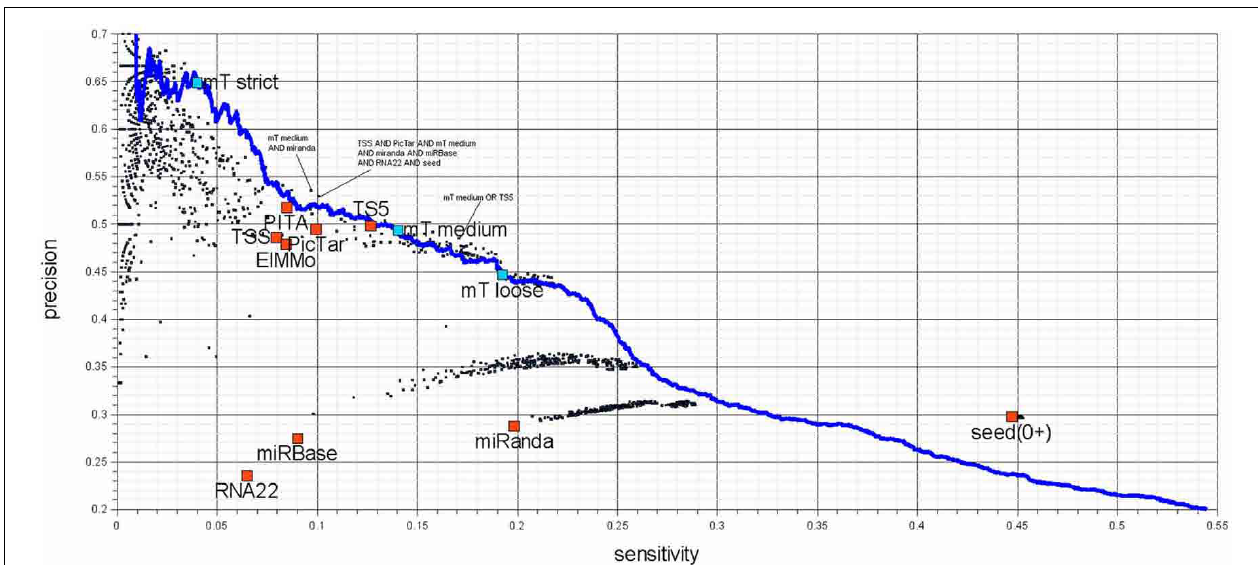
FIGURE 6 | Sensitivity – precision plot for 10 target-predictors (red) and all possible combinations of their predictions (black). The performance of DIANA-microT-ANN is measured at the three suggested score cutoffs (blue squares) as well as at all other score cutoffs (blue line). Union combinations contain all target genes predicted by any of the combined programs and intersection combinations contain target genes predicted commonly by all of the combined programs.The investigated programs are PicTar (Lall et al., 2006),TargetScanS (Lewis et al., 2003), TargetScan 5.0 (Friedman et al., 2009), PITA (Kertesz et al., 2007), ElMMo (Gaidatzis et al., 2007), RNA22 (Miranda et al., 2006), miRanda (John et al., 2004; obtained from mirna.org), miRBase-Targets (Enright et al., 2003; miRanda algorithm provided by